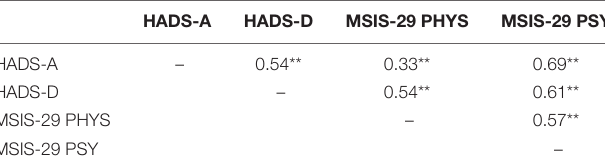
TABLE 4 | Pearson correlation coefficient for HADS and MSIS-29 scale ( N =